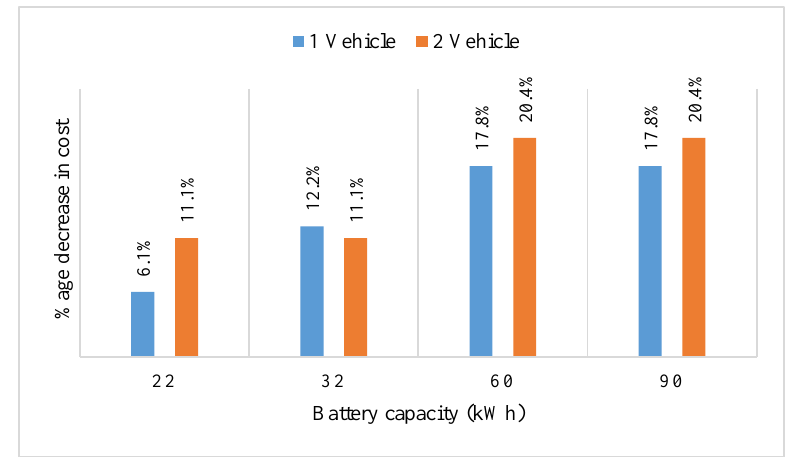
Figure 3. Percentage decrease in total traveling cost under different battery capacities. Table 14. The optimal solutions under different vehicle capacities ( Q k ).